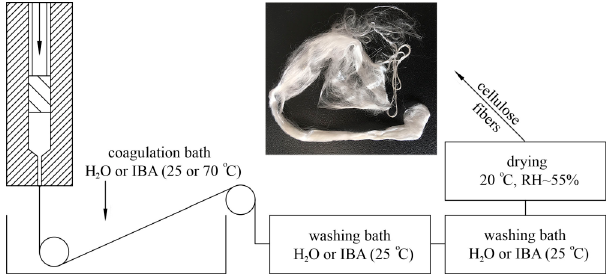
Figure 1. A scheme of the dry jet–wet fiber spinning process for cellulose– N -methylmorpholine- N -oxide (NMMO) solution.